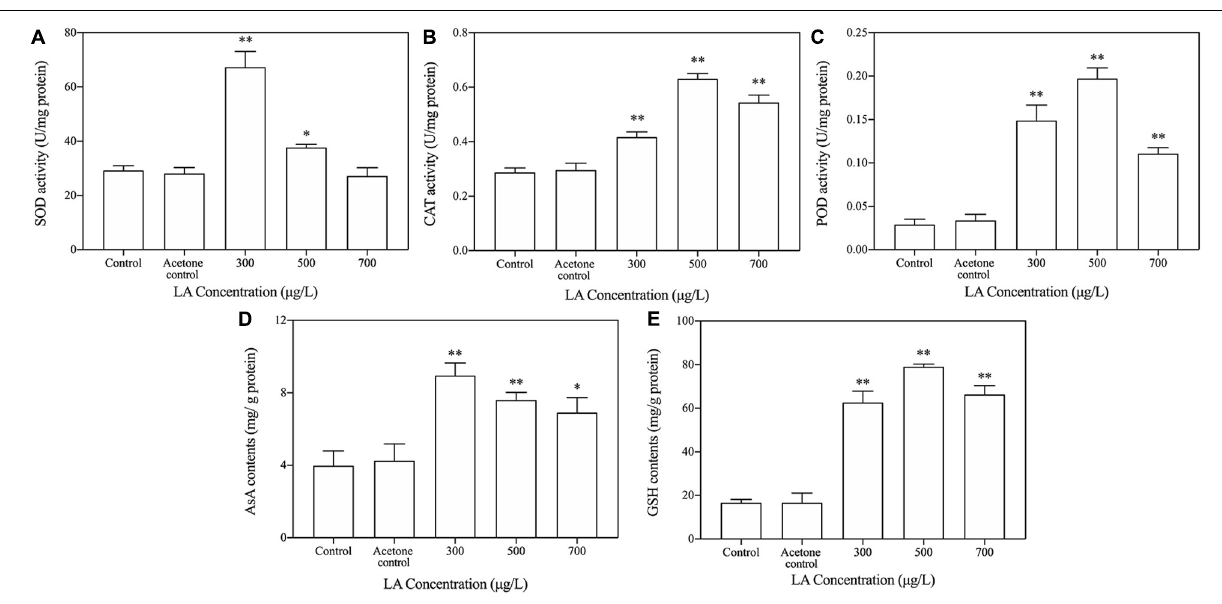
FIGURE 4 | Key enzymatic and non-enzymatic antioxidant responses to LA exposure in H. akashiwo . (A) SOD activities; (B) cat activities; (C) POD activities; (D) AsA contents; (E) GSH contents. The data are presented as the mean ± SD ( n = 3). Asterisks indicate significant differences from acetone control ( ∗ indicate p < 0.05; ∗∗ indicate p <